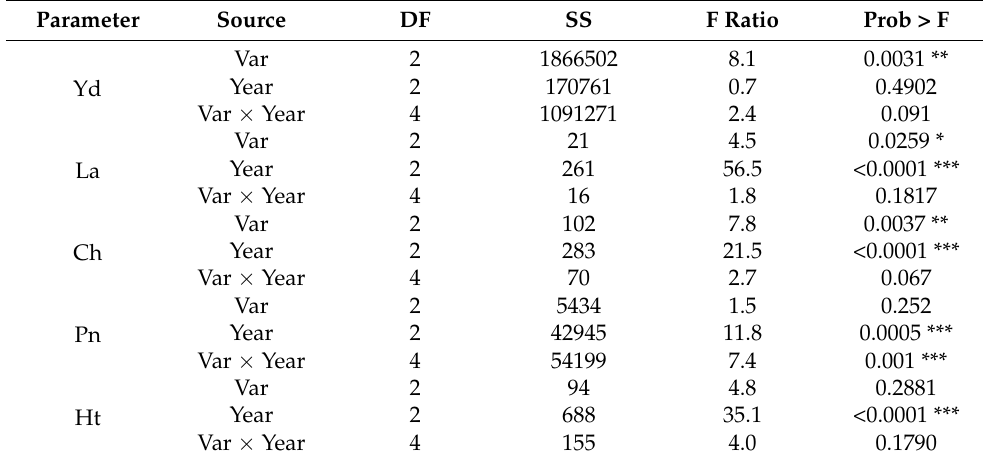
Table 2. The analysis of variance for leafy greens yield (Yd), leaf area (La), leaf chlorophyll content (Ch), plant height (Ht), and number of plants per unit area (Pn) of three varieties of quinoa grown in the high tunnel for leafy greens production in 2020, 2021, and 2022.